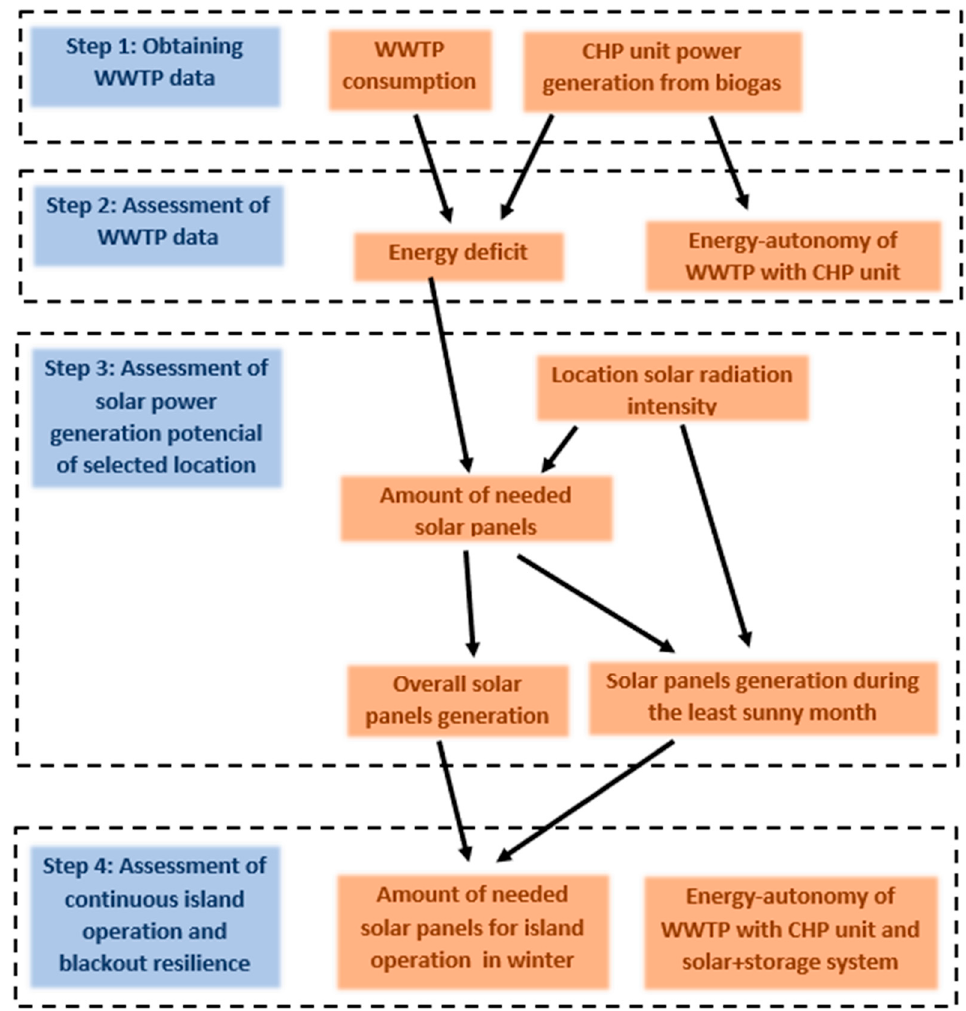
Figure 6. The assessment process.